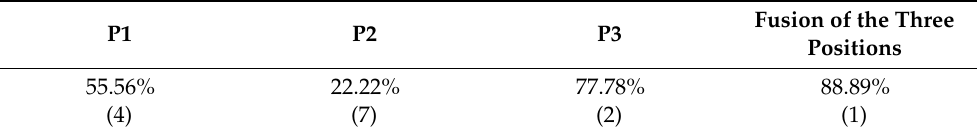
Table 6. Percent of correct decisions for each series with the synchronous